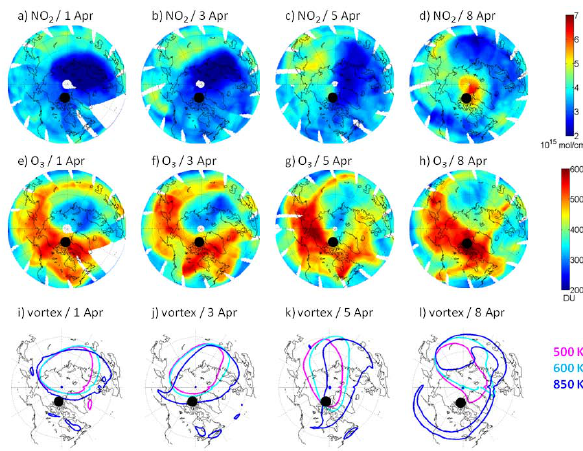
Fig. 4. Polar maps of OMI NO 2 stratospheric columns in molcm − 2 (top row), OMI ozone total columns in DU (middle row) and the approximate inner vortex edge (bottom row) for 1, 3, 5 and 8 April 2011. Small [large] column values are given in blue [red]. The inner vortex edge is approximated at sPV = 1 . 6 × 10 − 4 s − 1 for 500-K (magenta), 600-K (cyan), and 850-K (blue) potential temperature levels. Eureka is indicated by the black